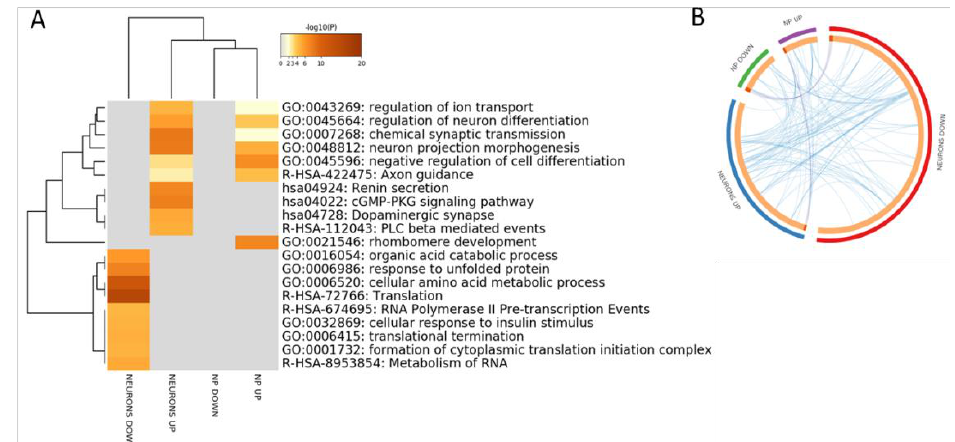
Figure 2. (A ) Hierarchical clustering of the top 20 most enriched terms by genes significantly modulated in Induced pluripotent stem cells (iPSCs)-derived neuronal progenitors cells (NP) and iPSCs-derived neurons from sporadic Alzheimer’s disease patients vs. healthy donors. The heatmap is colored by the p-values, and grey cells indicate the lack of significant enrichment; ( B ) Circos plot showing overlapping between the genes significantly modulated in iPSCs-derived neuronal progenitors cells (NP) and iPSCs-derived neurons from sporadic Alzheimer’s disease patients vs. healthy donors. Purple lines link the same genes that are shared by the input lists. Blue lines link the different genes that fall in the same ontology term.